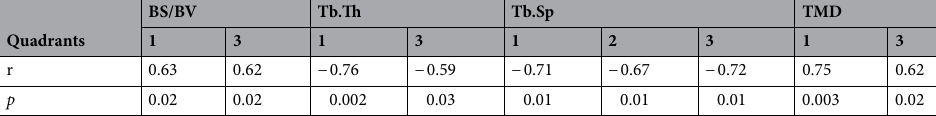
Table 3. Correlation between OA severity and microstructural parameters in all quadrants in trabecular bone. BS/BV, bone specific surface; Tb.Th, trabecular thickness, Tb.Sp, trabecular separation; TMD, tissue mineral density. The correlation coefficient, r, and p values are reported. p < 0.01 was considered significant.